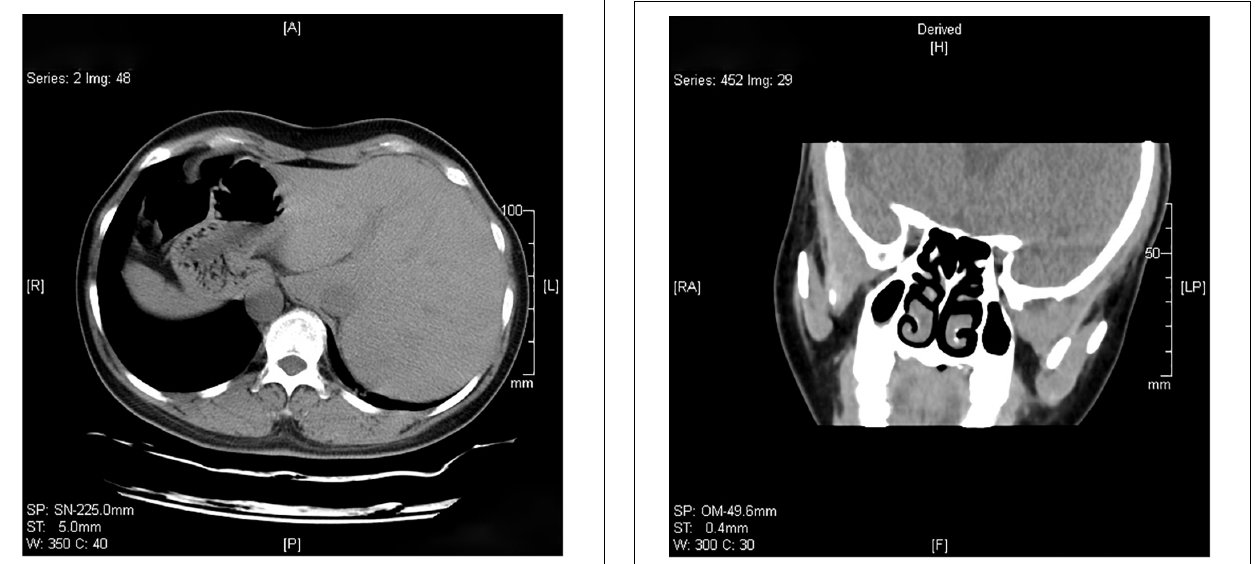
FIGURE 4 | The paranasal sinus CT scan of the proband shows non-specific thickening of the mucosa on the bilateral maxillary